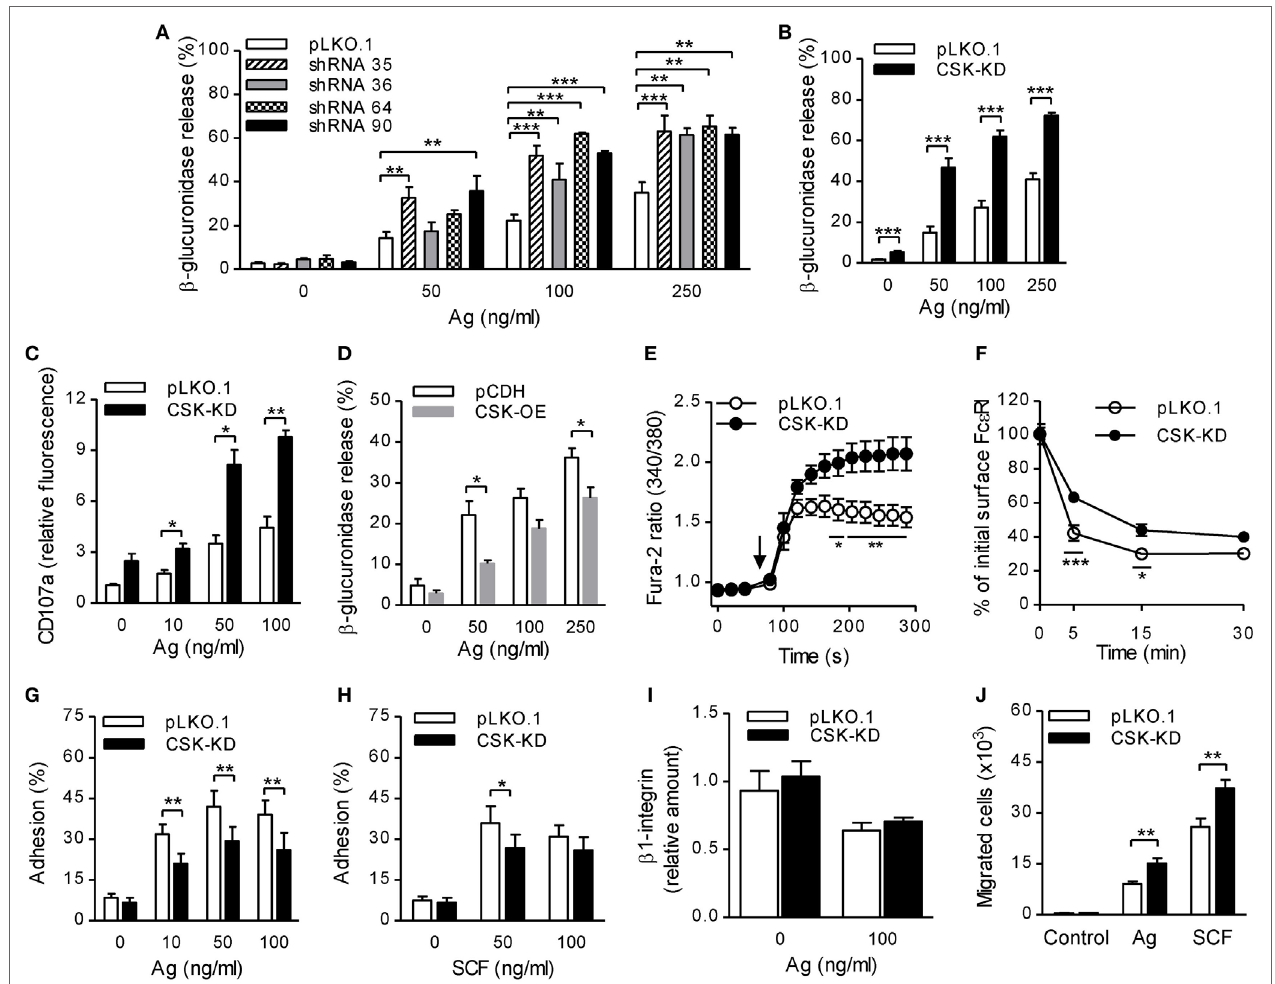
FigUre 1 | Enhanced degranulation, calcium response, and chemotaxis toward antigen and SCF, but reduced adhesion to fibronectin and Fc ε RI–IgE complexes internalization in bone marrow-derived mast cells (BMMCs) with C-terminal Src kinase (CSK)-KD. (a) β -glucuronidase release was analyzed in BMMCs transduced with individual CSK-specific shRNAs (35, 36, 64, or 90) in pLKO.1 vector or empty pLKO.1 vector (pLKO.1). The cells were sensitized with IgE and activated with various concentrations of antigen (Ag) for 30 min. The data represent means ± SEM from 4–8 independent experiments performed in duplicates or triplicates. (B) β -glucuronidase release from BMMCs transduced with a pool of shRNAs (CSK-KD) or empty pLKO.1 vector was examined as in (a) . The data represent means ± SEM from eight independent experiments performed in duplicates or triplicates. (c) Presence of CD107a on the cell surface in BMMCs with CSK-KD or empty pLKO.1 vector used as a control. The cells were sensitized with IgE, activated with various concentrations of antigen for 10 min and the presence